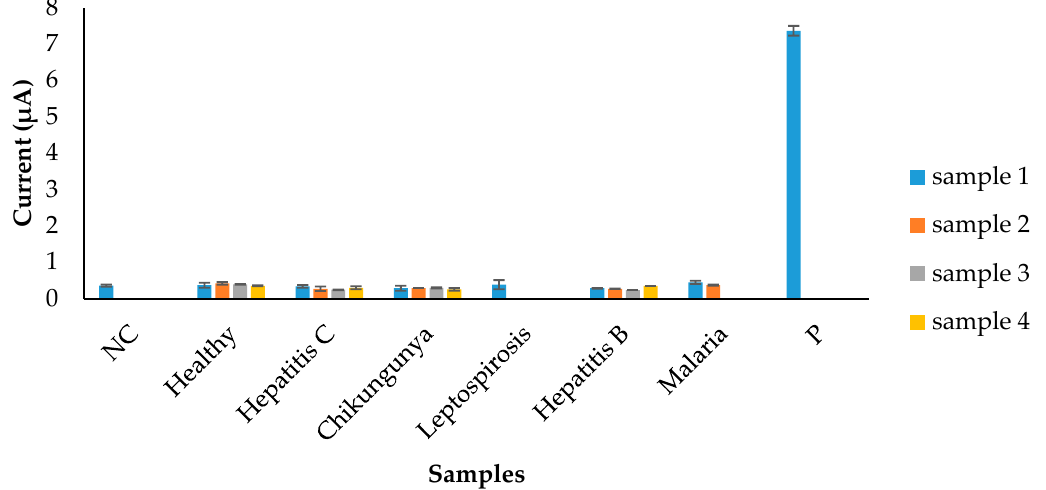
Figure 6. Analytical specificity evaluation of the electrochemical biosensor using serum samples from different infections. NC: background control against dengue IgM negative serum pool, P: positive detection against target dengue IgM positive serum pool.